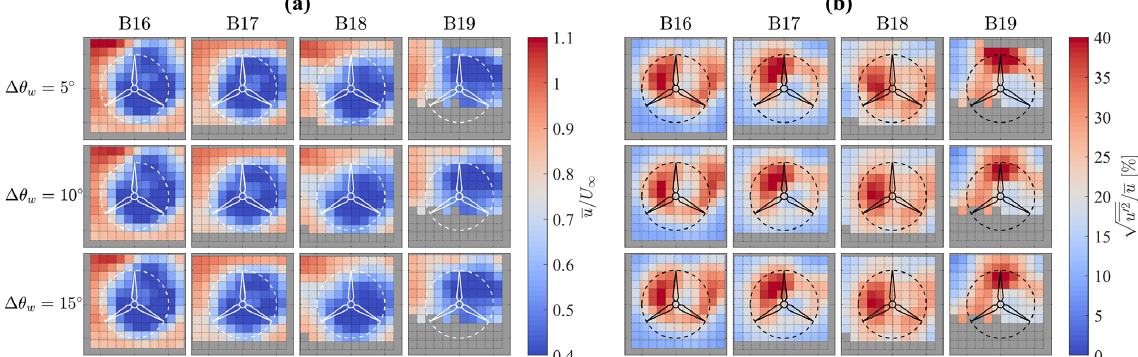
Pareto front is shown in Fig. 16, which indicates (cid:49)θ = 0 . 5